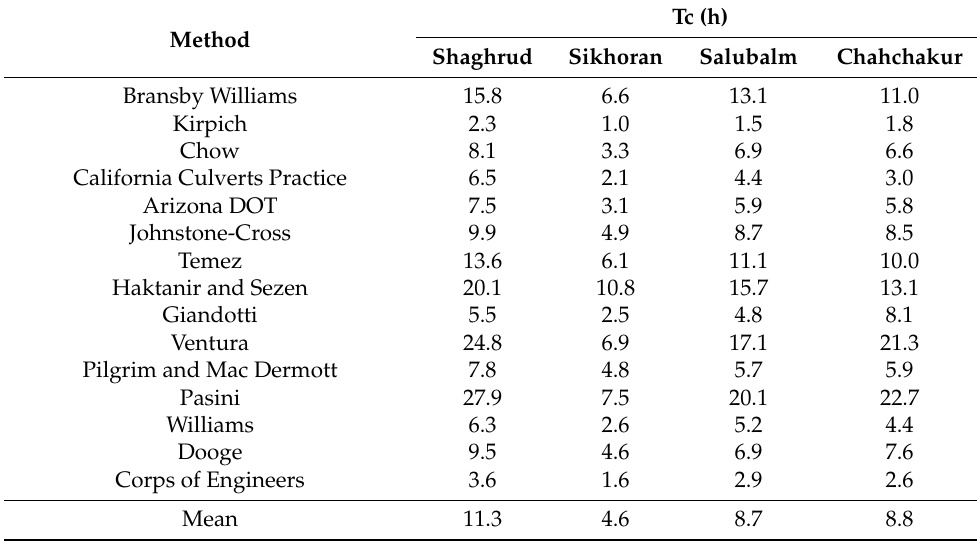
Table 4. Values of Tc in sub-watersheds determined by applying empirical